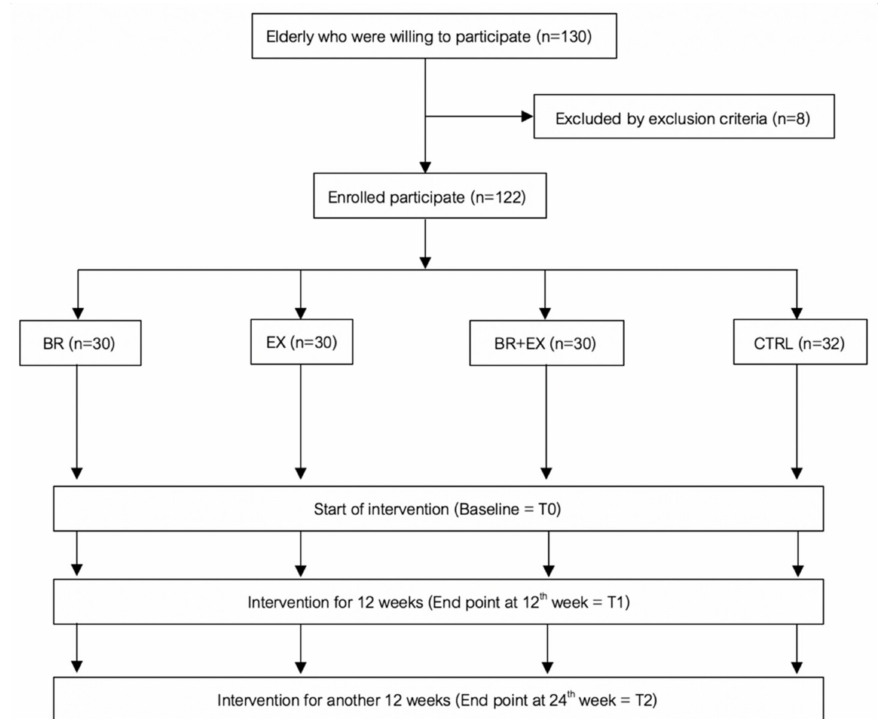
Figure 1. Diagram of sample selection and intervention study design for the aging population (BR = Black rice germ and bran supplement intervention group, EX = Exercise intervention group, BR + EX = Combined intervention of supplement intake and exercise intervention group and CTRL = Control